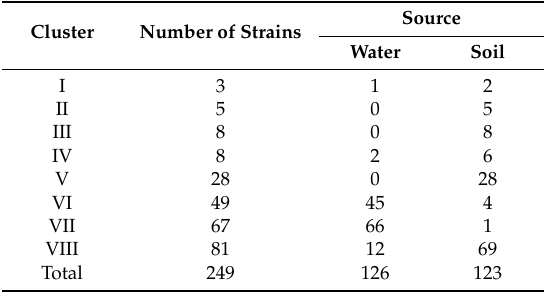
Table 2. Cluster of multidrug-resistant bacteria isolated from water and soils, based on the kind of antibiotic presenting